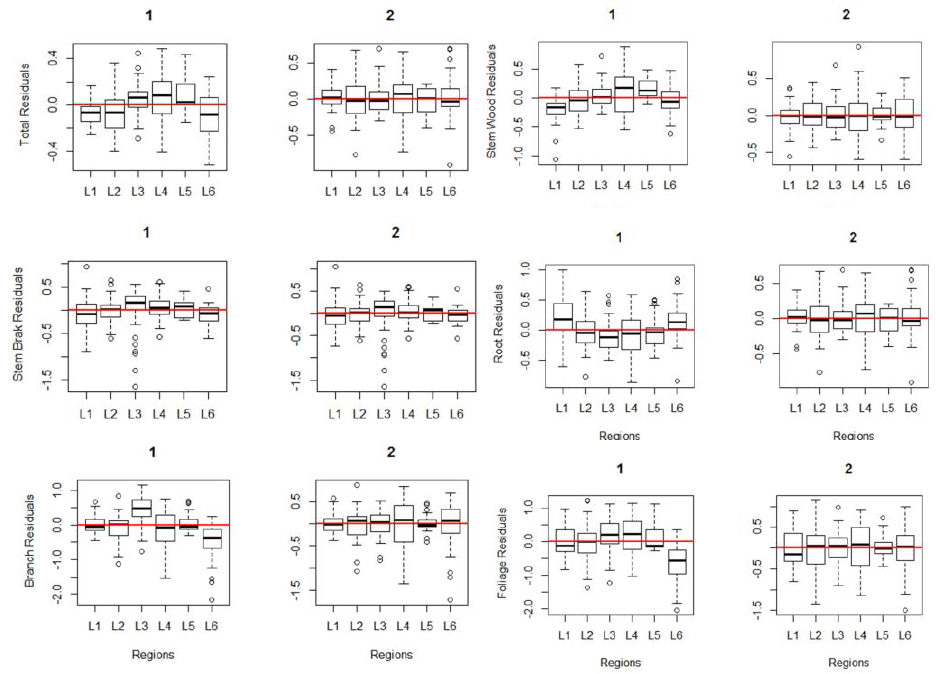
Figure 5. Residual boxplots comparing the non-hierarchical and hierarchical Bayesian approaches. 1 and 2 represent the non-hierarchical and hierarchical Bayesian approaches,